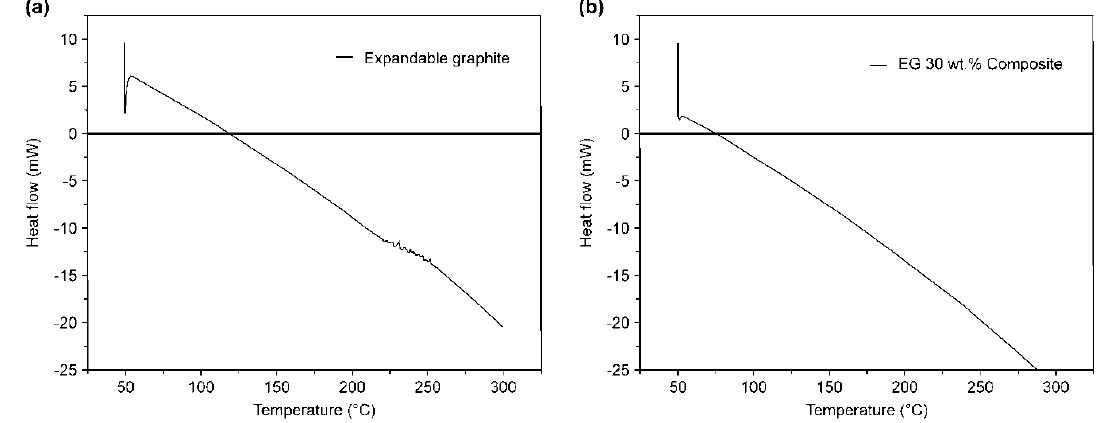
Figure 2. DSC analysis of the expandable graphite ( a ) and EG 30 wt.% composite ( b ).